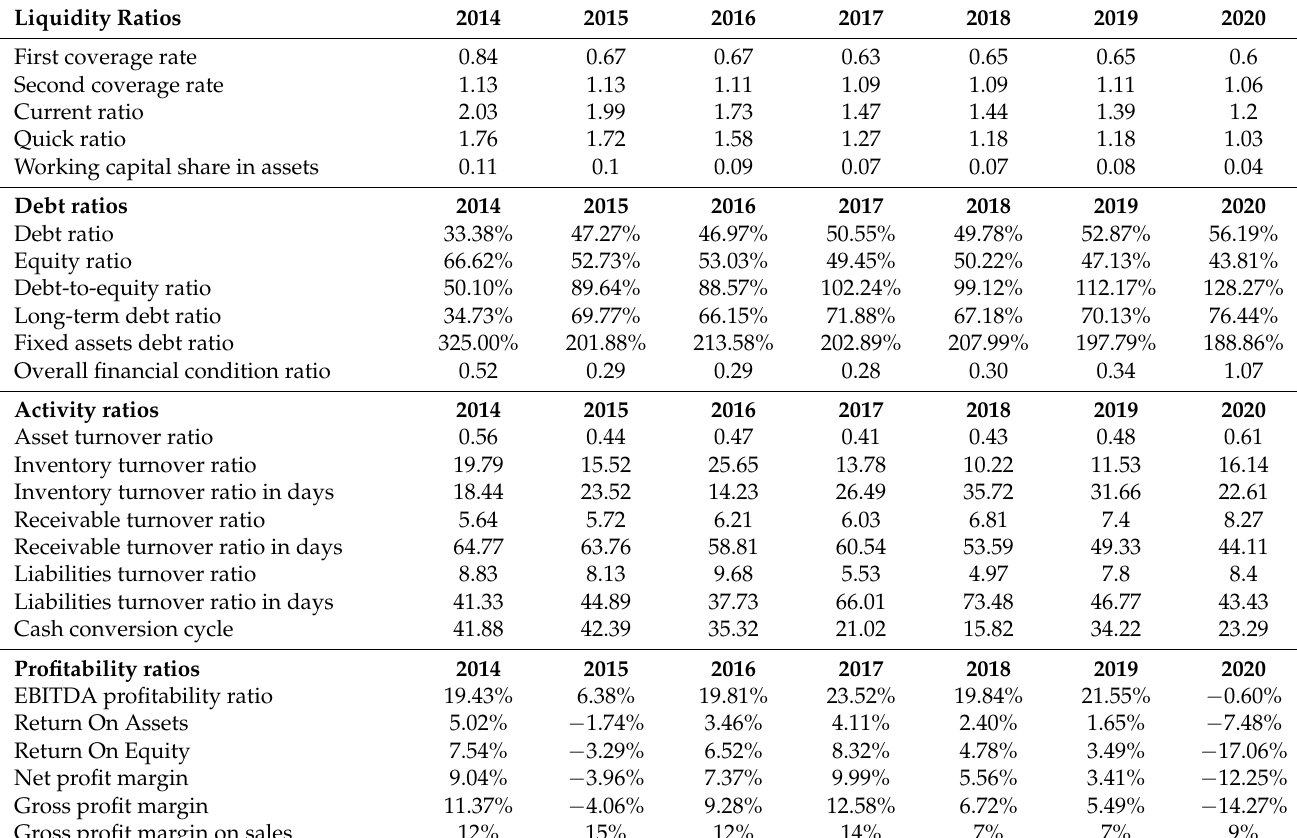
Table 12. Financial ratios of ENEA capital group in the years 2014–2020.